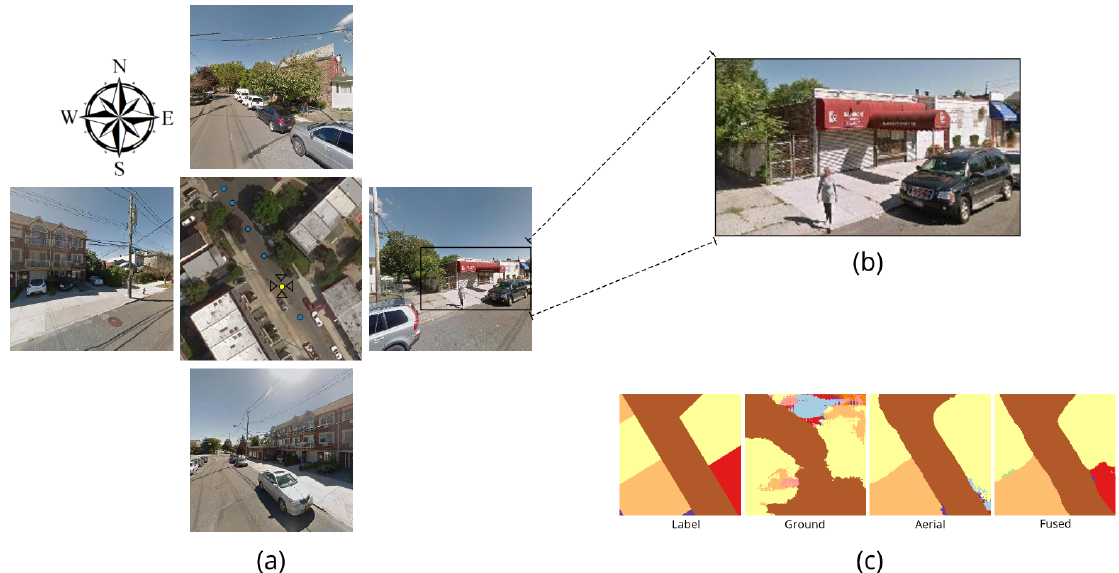
Figure 12. Case study on segmentation results from Queens test set. ( a ) Aerial and street view images; ( b ) Zoomed view of the building to the east; ( c ) Corresponding segmentation